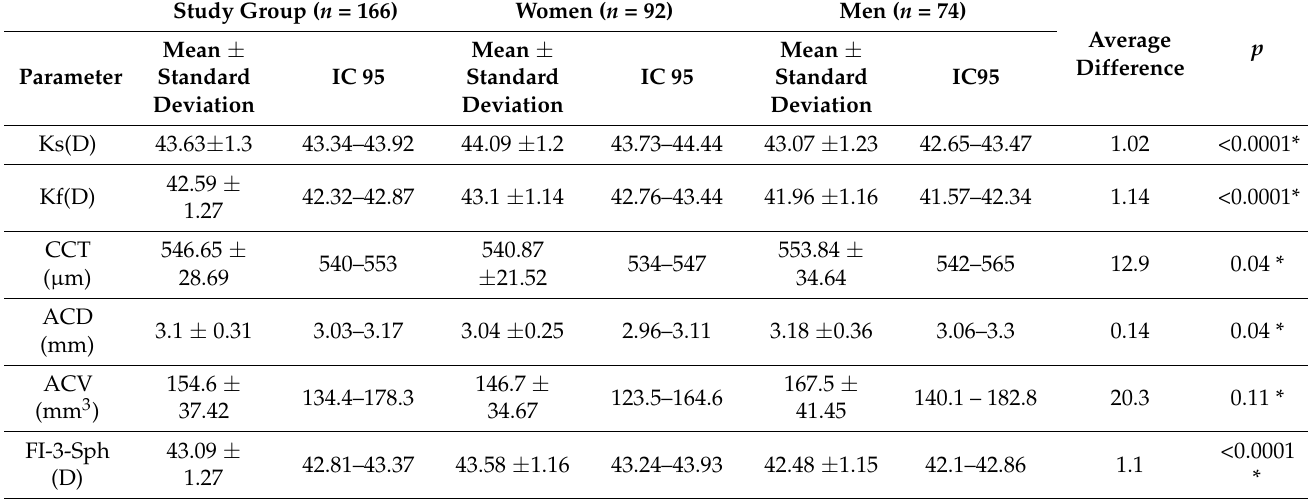
Table 2. Comparison of the results of the normally distributed parameters of the anterior segment in the studied groups. Study Group ( n =